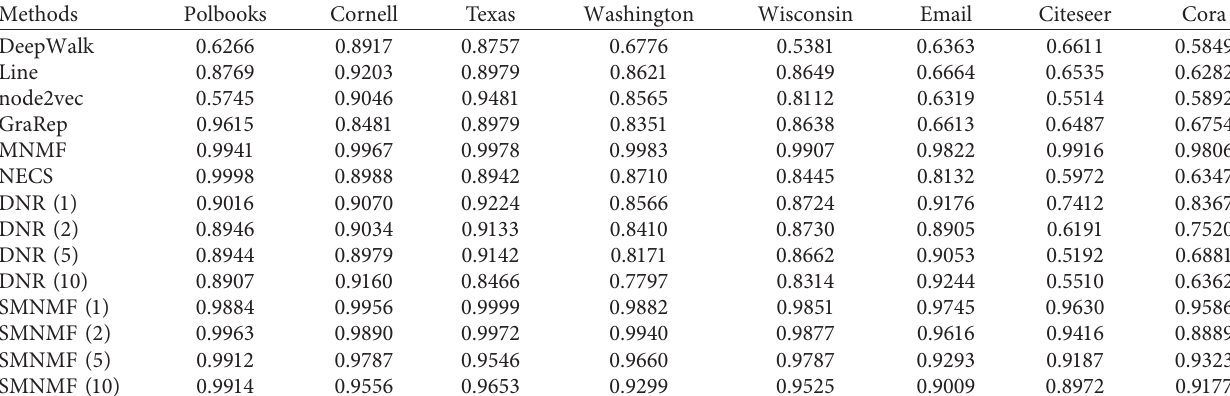
Figure 1: The accuracy of SMNMF with different proportion prior information on eight datasets. Table 4: AUC-ROC of link prediction (90% training set and 10% test